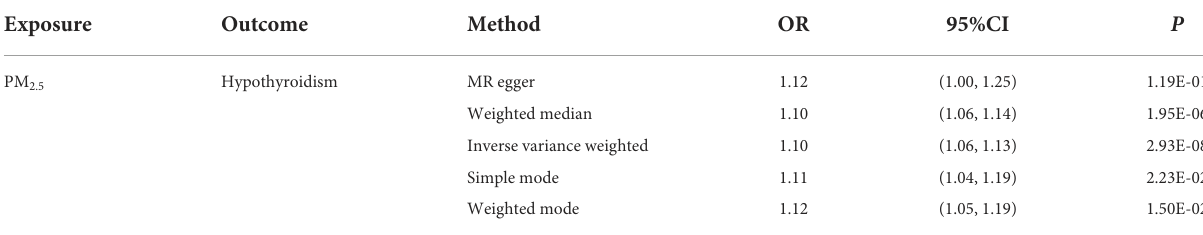
TABLE 3 Two-sample Mendelian randomization analysis results between PM 2.5 and hypothyroidism.